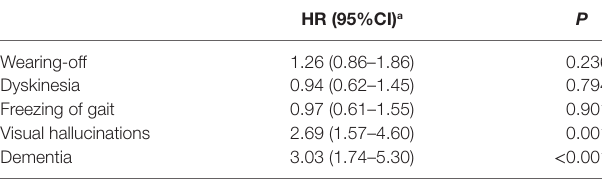
TaBle 3 | Multivariate Cox’s regression model on all study population.